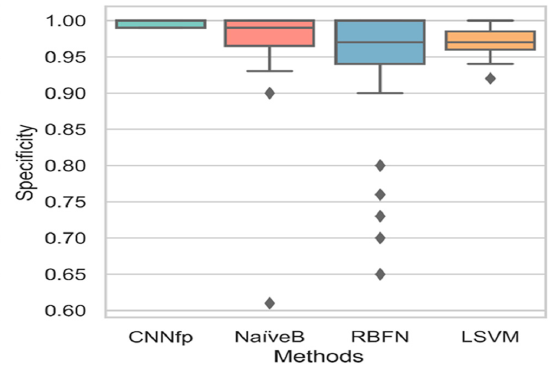
Figure 10. Boxplot chart results based on comparing the specificity values of different algorithms: CNNfp, NaiveB, RBFN, and LSVM.